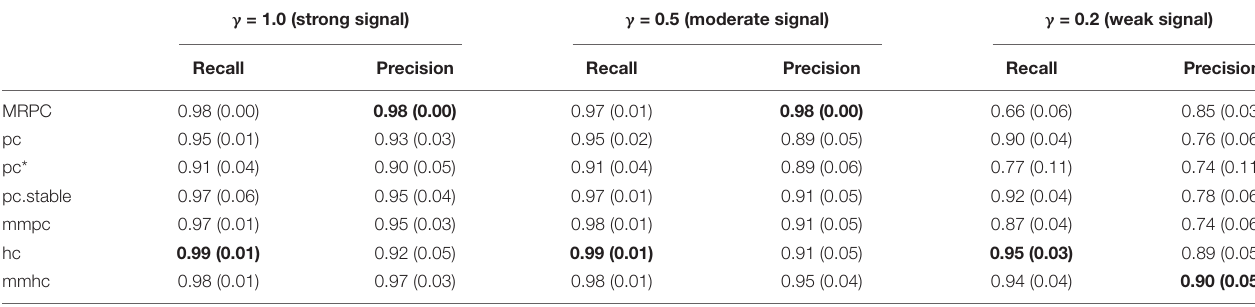
TABLE 2 | Comparison of inference accuracy on the complex graph in Figure 3A . γ = 1.0 (strong signal) γ = 0.5 (moderate signal) γ = 0.2 (weak signal)